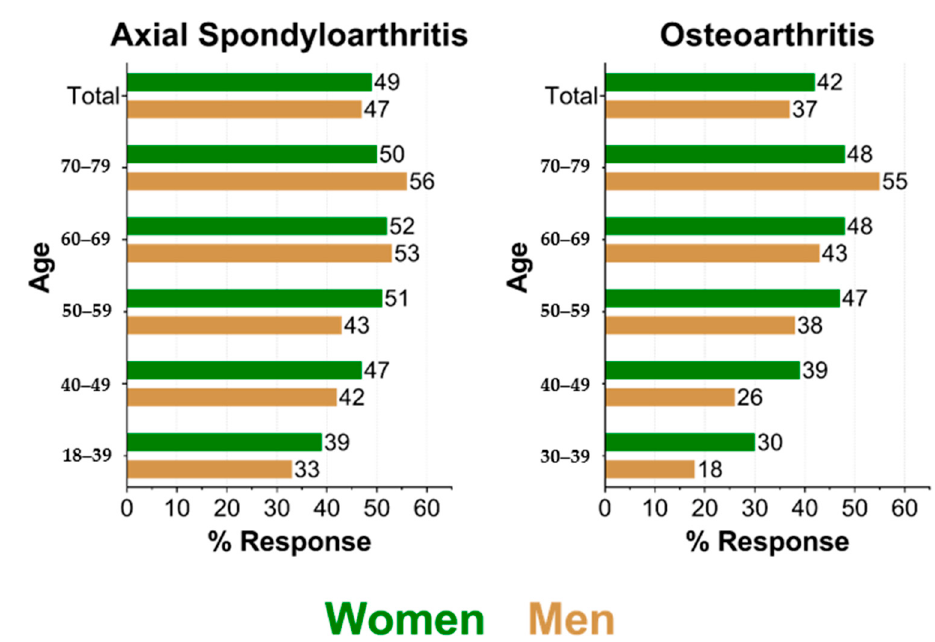
Figure 1. Flowchart showing sample sizes in the surveys.